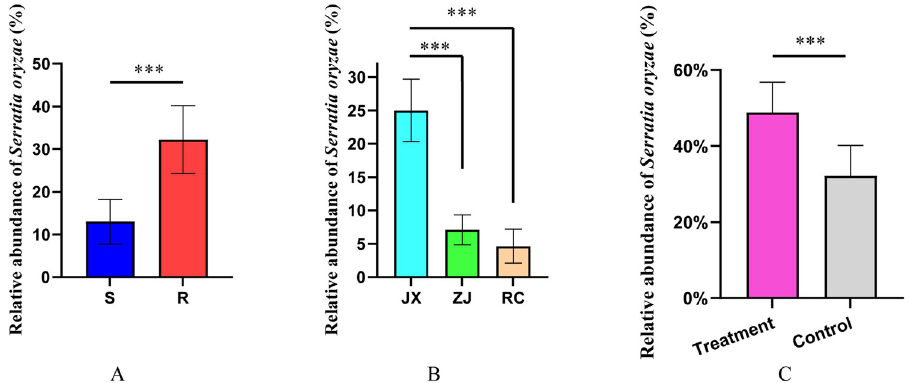
Fig 2. The relative abundance of Serratia oryzae of resistant mosquitoes significantly higher than that of sensitive mosquitoes (A); The relative abundance of Serratia oryzae of JX mosquitoes, that is field resistant mosquitoes, significantly higher than that of ZJ and RC mosquitoes (B); The relative abundance of Serratia oryzae of deltamethrin- treated mosquitoes significantly higher than the control groups